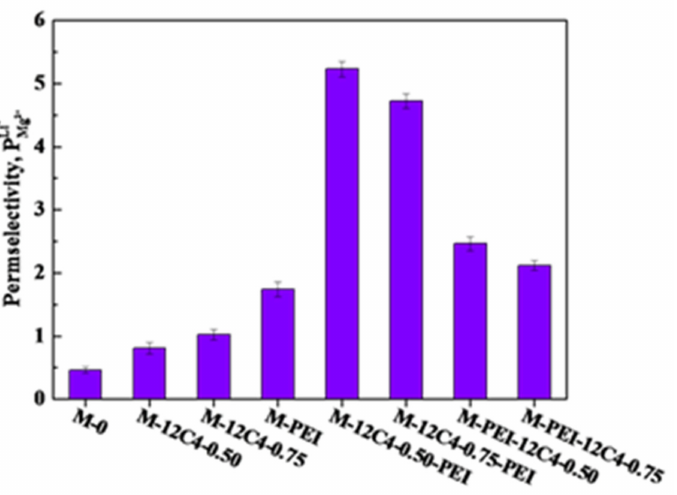
Figure 9. Permselectivity for the pristine (M-0) and modified (M-PEI, M-12C4-x, M-12C4-x-PEI, M-PEI-12C4-x, x = 0.50 and 0.75) membranes in 0.05 M binary mixture of LiCl and MgCl 2 at current density of 5.0 mA · cm − 2